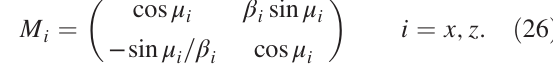
FIG. 5. Eigentune for l